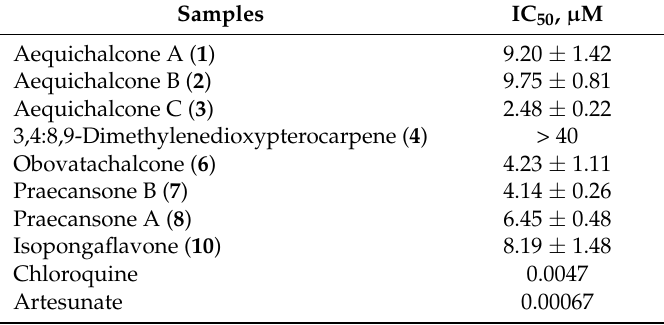
Table 4. In vitro antiplasmodial activities of isolated compounds and against 3D7 strains of P. falciparum